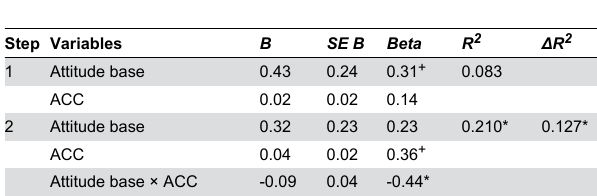
Table 2. Effects of attitude base and affective-cognitive consistency on attitude-behavior relation for intergroup instrumental behaviors in Study